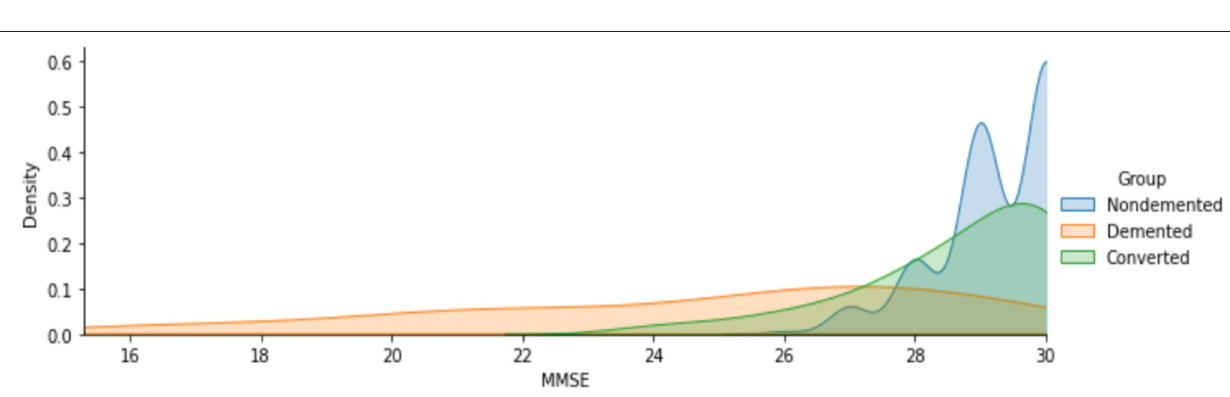
and F-score. Based on this study, recall (sensitivity) is the proportion of people accurately classified as having